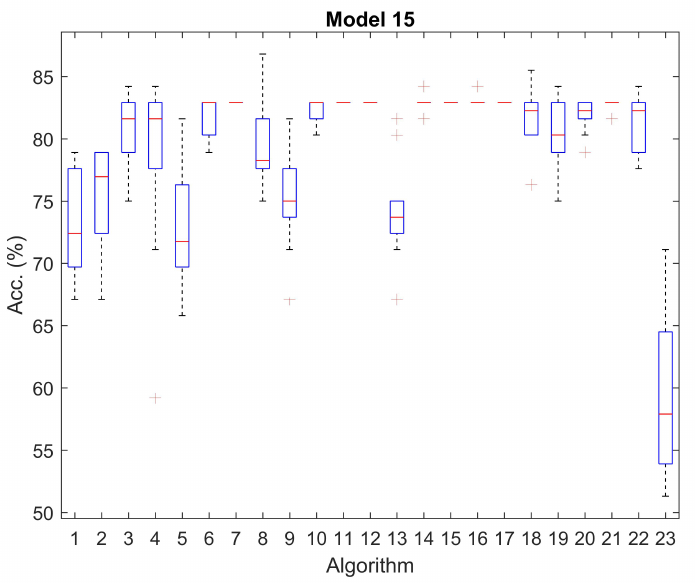
Figure 7. Accuracy of Model 15 for the different algorithms. The 23 algorithms are represented in the x -axis, and the accuracy is shown in the y -axis.